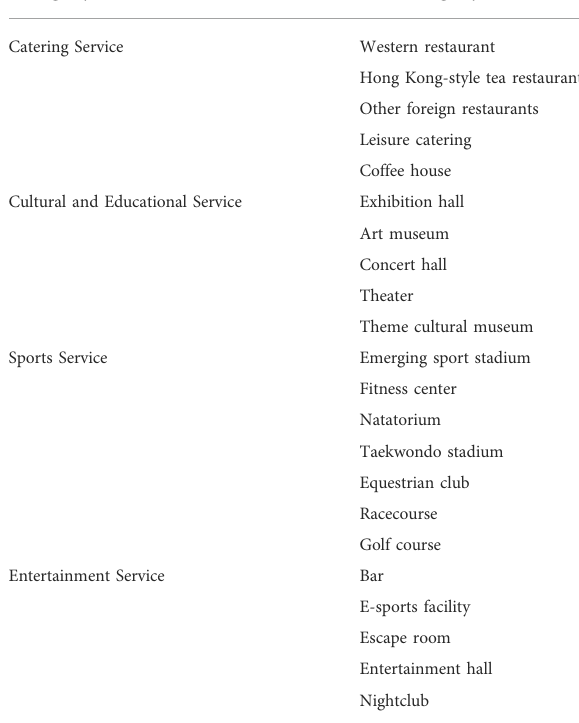
TABLE 1 Categories of retail places representing emerging